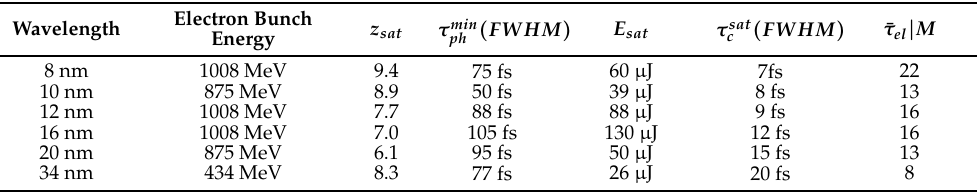
Table 1. Main parameters derived from the measurements shown in Figure 3. The values were deduced from scaling the experimental data to the 3D simulation, with z sat as saturation length in ( FWHM ) “number of undulators” with a maximum number of undulators of 12 at FLASH2, τ min ph as minimum pulse duration, and E sat as the saturation pulse energy. In order to compare the experimental data to the 1D simulation, the normalized electron pulse duration ¯ τ el (equivalent to the number of modes M) was determined for all measured wavelengths using Equation (4), and the coherence time at saturation τ sat c (FWHM) was taken from Refs. [19,33]. ( FWHM Wavelength Electron Bunch Energy z sat τ min ph